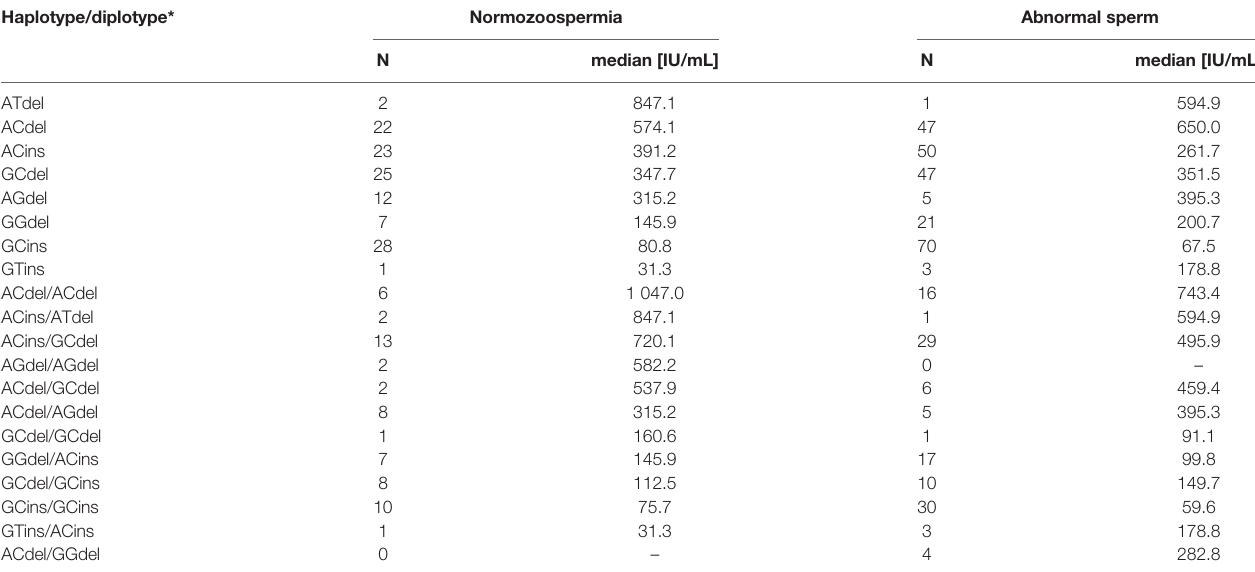
*Haplotypes/diplotypeswereestimatedinthefollowingorder:rs1632947:-964G>A;rs1233334:-725G>C/T;rs371194629:insATTTGTTCATGCCT/del.Normozoospermia – totalnumber of sperm cells, their concentration, progressive motility and morphology above or equal reference values; Men with abnormal sperm – men with at least one parameter of semen below reference